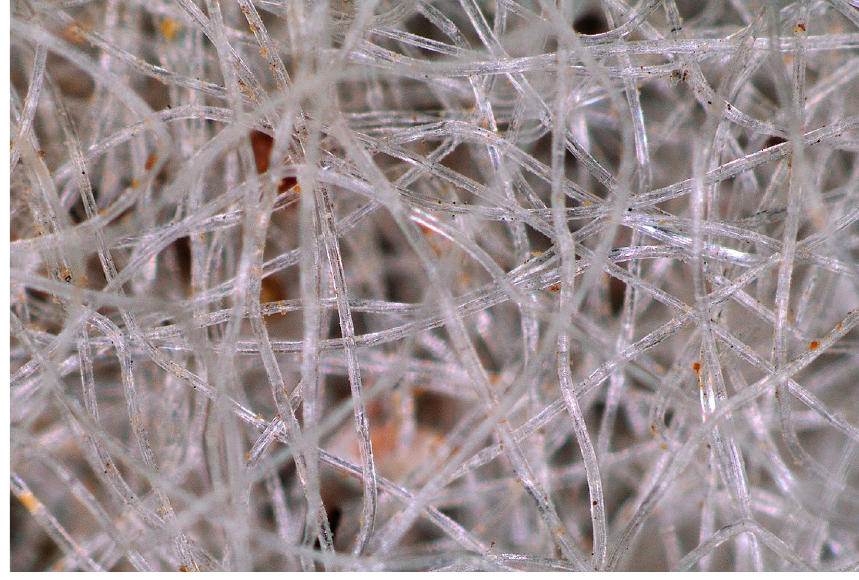
Figure 2. Microscopic image of nonwoven surface of virgin GCL at 32× magnification.